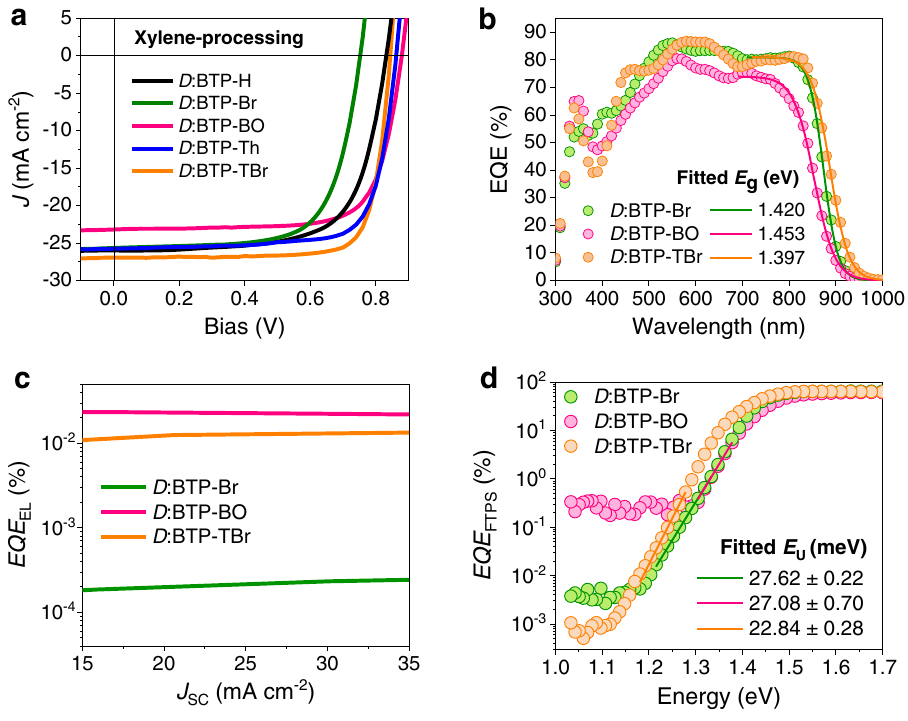
Fig. 2 | Photovoltaic performance and energetic analysis. J − V characteristic ( a ) and EQE spectra ( b ) for conventional devices processed by xylene, where D representsPTzBI- d F;thebandgapoftheblendswasobtainedfromsigmoidal fi tting